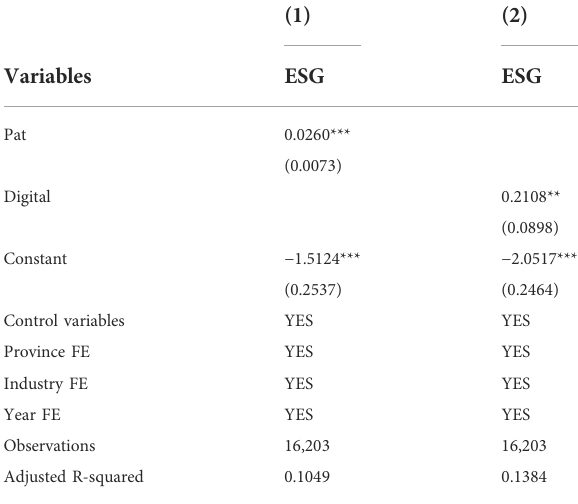
TABLE 9 Impact of digital economy development on ESG performance:Substitutionofcoreexplanatoryvariableandtestof missing variables.